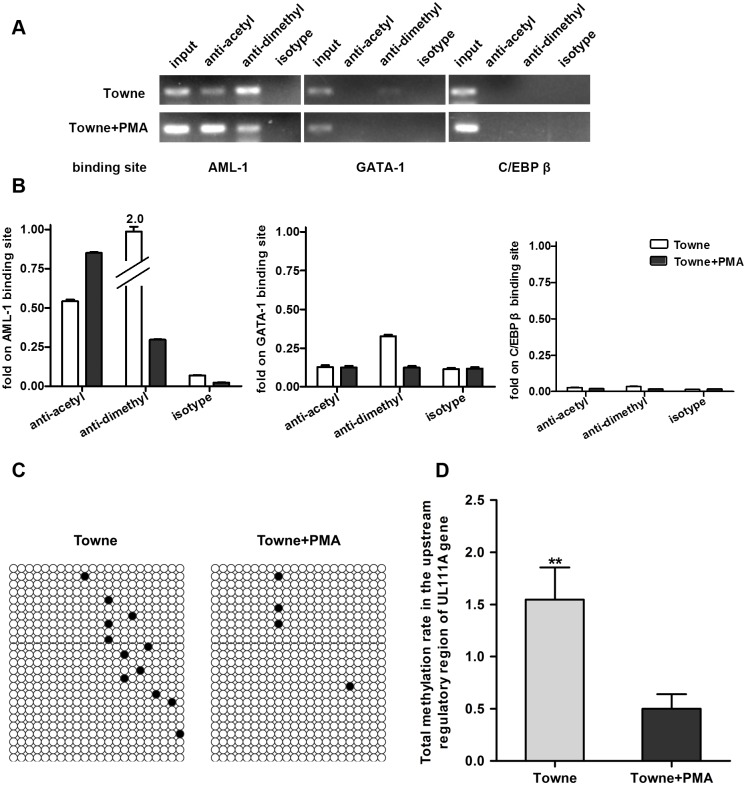
Epigenetic modification status in the URR of UL111A from undifferentiated and differentiated HCMV-infected THP-1 cells.(A) ChIP analysis showing the association of the transcription factors binding sites with histone H3 acetylated at K9 position (H3 acetyl-K9) and dimethylated at K9 position (H3 dimethyl-K9). The lanes are designated as: “input”—PCR amplification of input DNA, “anti-acetyl”—PCR amplification of the chromatin DNA fragments precipitated by antibody against H3 acetyl-K9, “anti-dimethyl”—PCR-amplification of the chromatin DNA fragments precipitated by antibody against H3 dimethyl-K9, “isotype”—a negative control for non-specific reactions. (B) Quantitative analysis of the data in (A) from three independent ChIP experiments. The results were normalized to the input signal, which was set to 1. (C) Methylation status of the CpG sites in the URR of the UL111A gene in undifferentiated and differentiated infected THP-1 cells infected with HCMV. The methylation status of individual CpG dinucleotides is indicated as: ○ and ●, which represent unmethylated and methylated cytosine, respectively. (D) Quantitative analysis of the total methylation data in (C) from three independent BSP experiments. **P < 0.01.